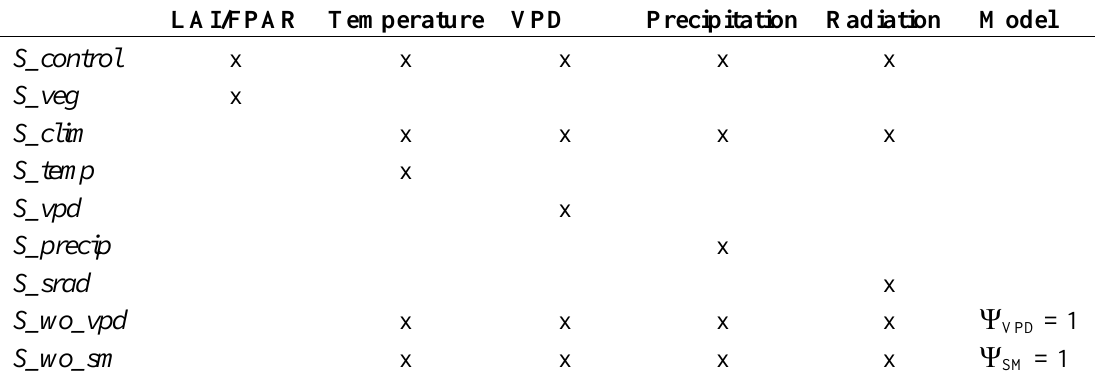
Table 1. Terrestrial Observation and Prediction System (TOPS) simulations naming convention. For each simulation, X indicates the variables allowed to vary while the climatology was used for the remaining variables. For the simulations with either Ψ or Ψ = 1, the down regulation function of either Vapor Pressure Deficit (VPD) or soil SM moisture was set to 1 so to have no control on Gross Primary Production (GPP). S_control was the GPP simulation with changing all the input variables. S_veg was the simulation driven by only Leaf Area Index (LAI)/FPAR, and the trend of S_veg was made from GIMMS 3g trend. S_clim was the simulation driven by climate variables, and represented the GPP trend explained by climate variability. S_temp , S_vpd , S_precip , and S_srad were driven by temperature, VPD, precipitation, and shortwave radiation,